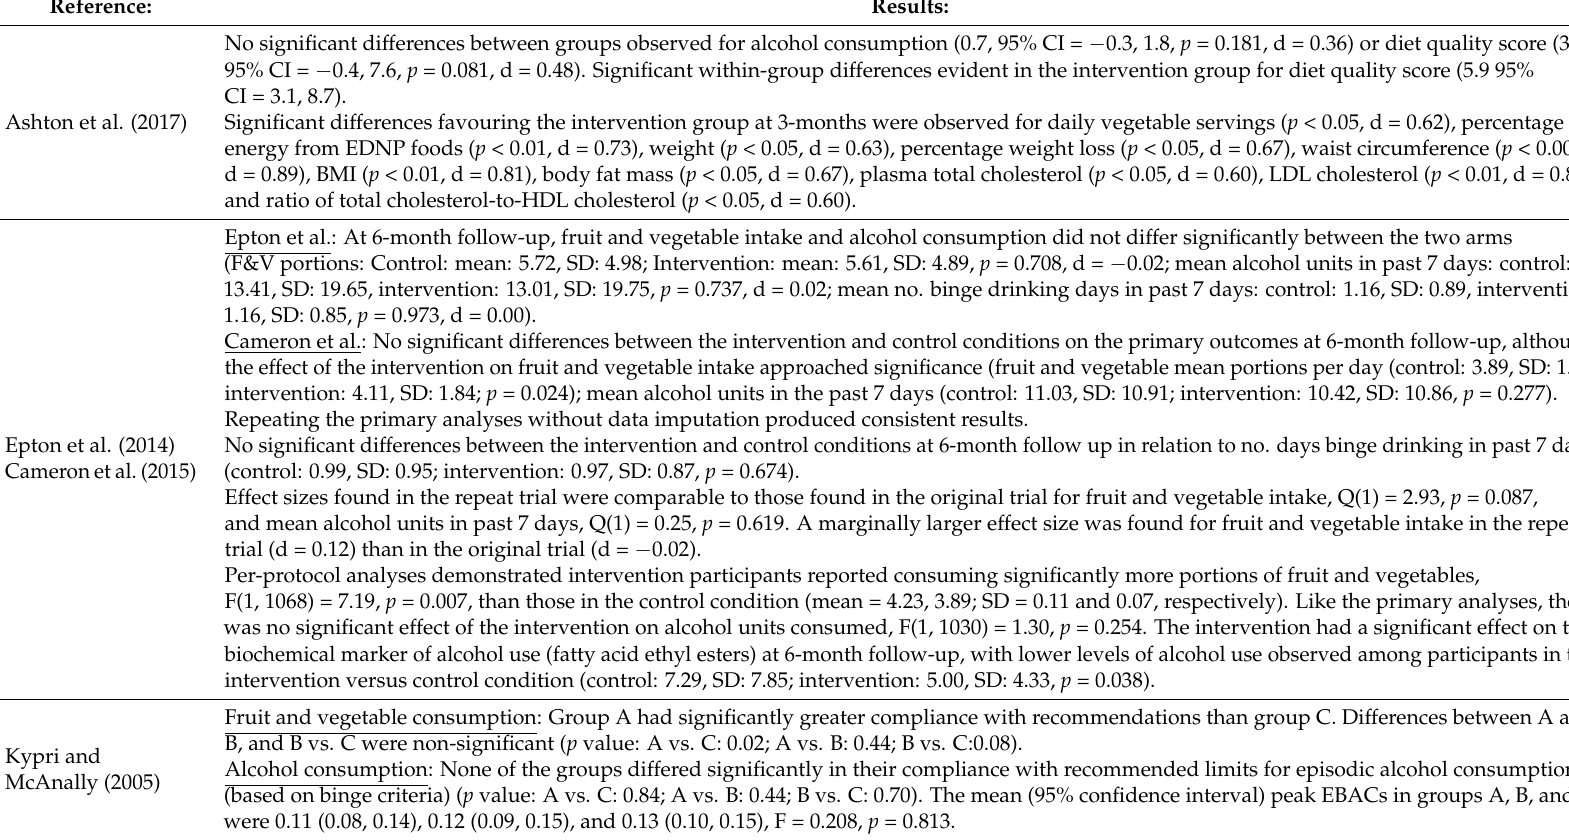
Table 2. Key study results against behavioural outcome